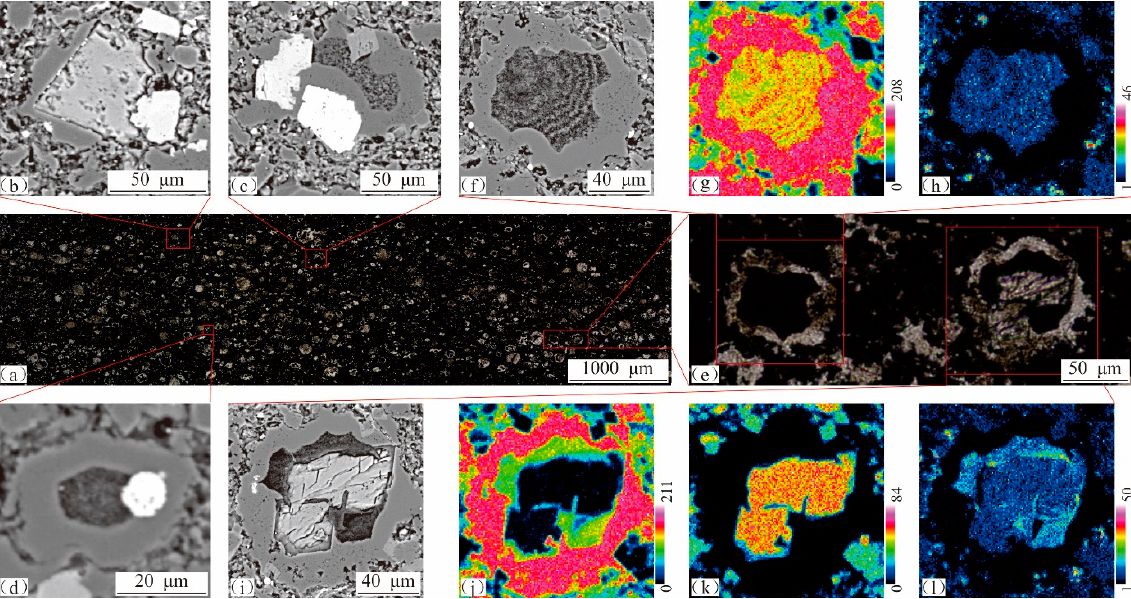
Figure 3. Typical images of fillings of radiolarian siliceous shell cavities under optical microscope and electron probe microscope. ( a ) Radiolarian ‐ rich siliceous shale lamina with length of 6.9 mm and width of 1.8 mm. ( b ) Uncompleted radiolarian siliceous shell, cavity filled with calcite and pyrite. ( c ) Uncompleted radiolarian siliceous shell, filled with calcite, pyrite and organic–silicon complex. ( d ) Complete radiolarian siliceous shell, filled with pyrite and organic–silicon complex. ( e ) Complete radiolarian siliceous shell, filled with calcite (white) and organic–silicon complex (black). ( f ) Spectral image of radiolarian siliceous shell on the left of image ( e ). ( g ) The scanned silicon ele ‐ ment of image ( f ). ( h ) The scanned carbon element of image ( f ). ( i ) Spectral image of radiolarian siliceous shell on the right of image ( e ). ( j ) The scanned silicon element of image ( i ). ( k ) The scanned calcium element of image ( i ). ( l ) The scanned carbon element of image ( i ). ( a , e ): Plain light. ( b – d , f , i ): Spectral image. ( g – h , j – l ): Element scanning. Table 2. In situ detected chemical compositions of calcites in radiolarian siliceous shell cavities. No.